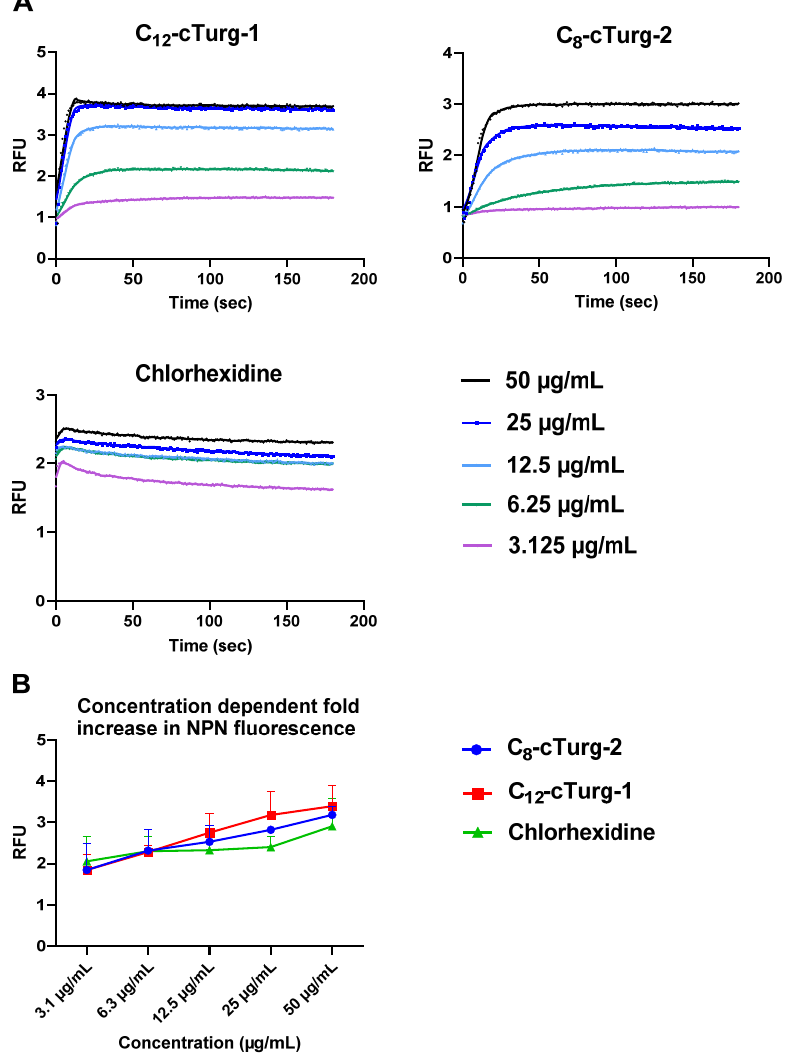
Figure 5. ( A ) Comparison of the effects of C 12 -cTurg-1 , C 8 -cTurg-2 and chlorhexidine on the kinetics of NPN fluorescence in E. coli MC4100 (WT). After addition of the bacterial inoculum (mixed with 20 µM NPN) to the wells (preloaded with lipopeptides), light emission was measured each second for 3 min. Each colored line represents the total 180 s data points from the assay at different concentrations. Each figure shows a representative data set. ( B ) E. coli MC4100 grown in MH media were treated with different concentrations of C 12 -cTurg-1 , C 8 -cTurg-2 and chlorhexidine. The permeability of the outer membrane was assessed by measuring the fluorescence of NPN after 3 min (mean of three independent measurements). In all data sets, fluorescence values were compared to bacterial cells treated with the same amount of Mill-Q water control.